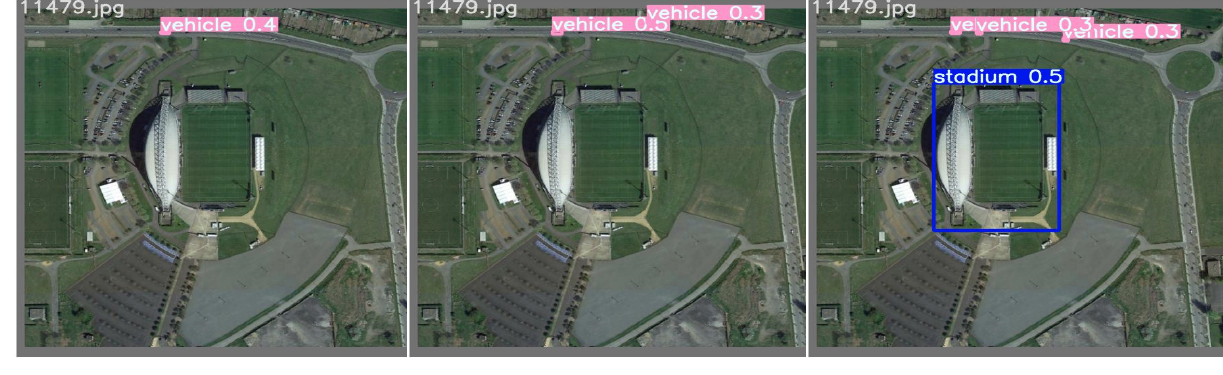
Figure 13. The example detection results in background